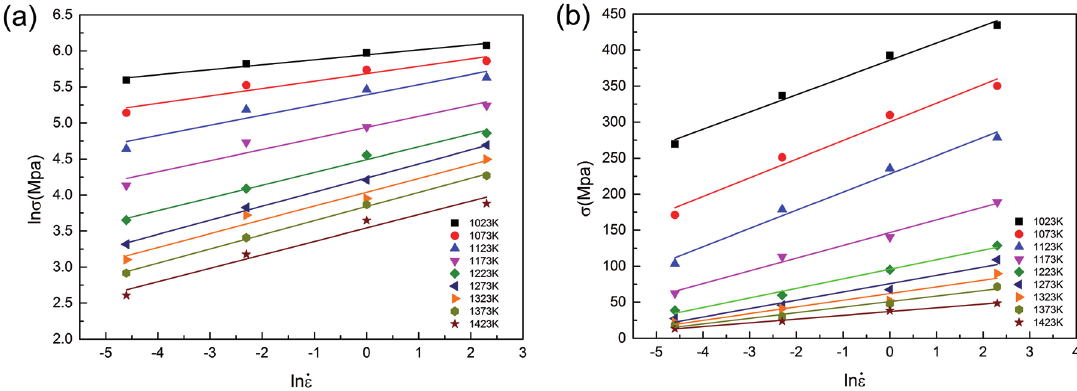
Figure 4: Plots of (a) ln σ versus ln f o , and (b) σ versus ln f o .